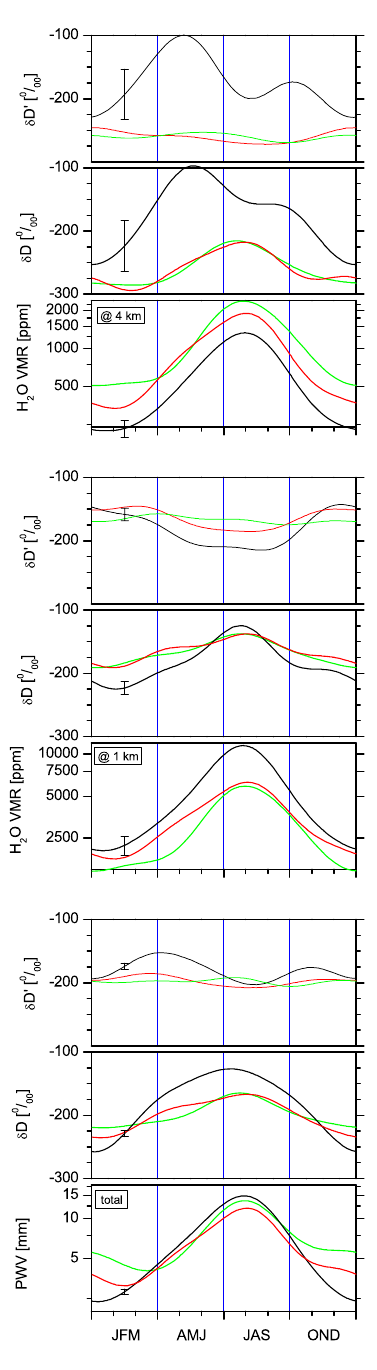
Fig. 8. Annual cycles for H 2 O, δ D, and δ D 0 for Kiruna. Panels from the bottom to the top: column integrated atmosphere, lower free troposphere, and middle troposphere. Black line: FTIR, red line: nudged run IsoGSM, green line: free run IsoGSM. The error bars at mid February indicate the estimated systematic error of the FTIR